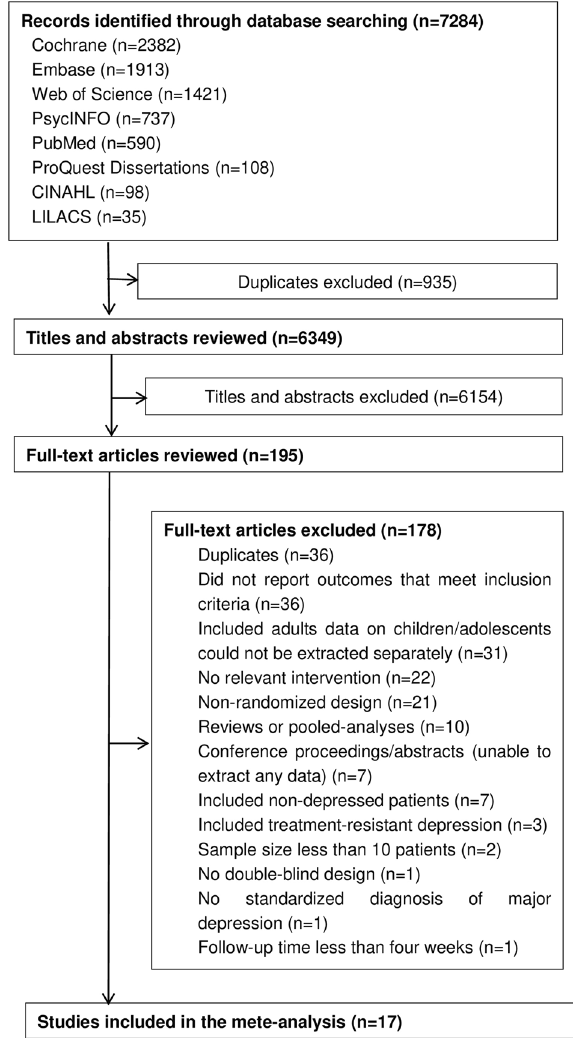
Fig. 1 Flowchart of study selection. Of the 7284 relevant studies, 935 were excluded because of duplication, 6154 were excluded because their titles and abstracts did not meet the inclusion criteria, and 178 studies were excluded in full-text screening. 17 RCTs were fi nally